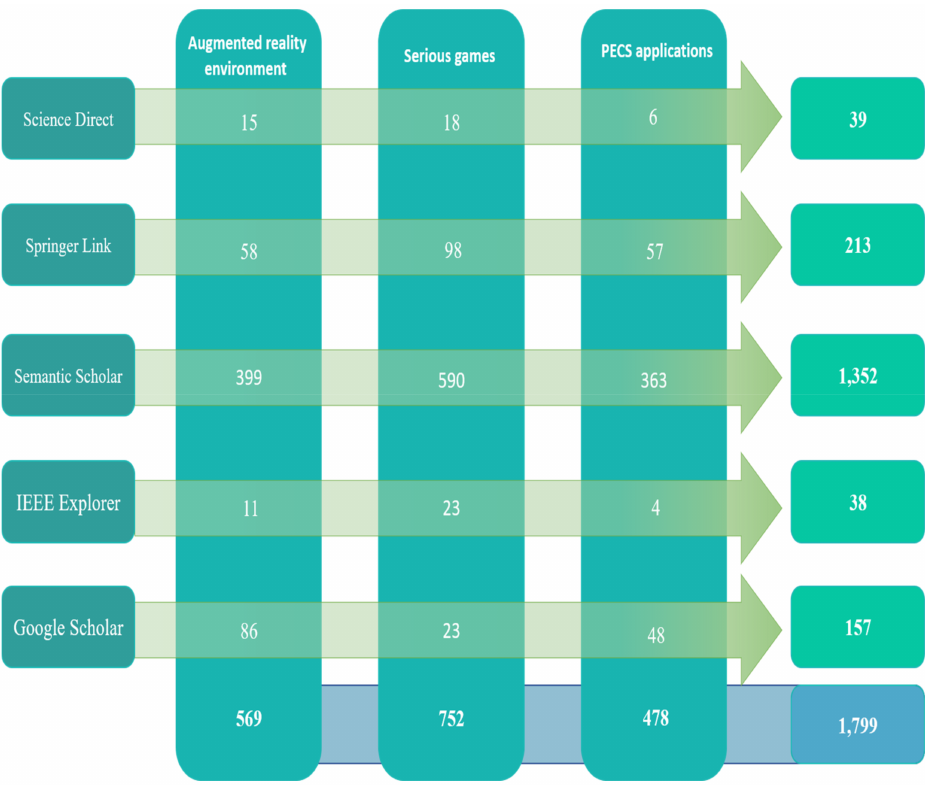
Figure 10. Search results from search